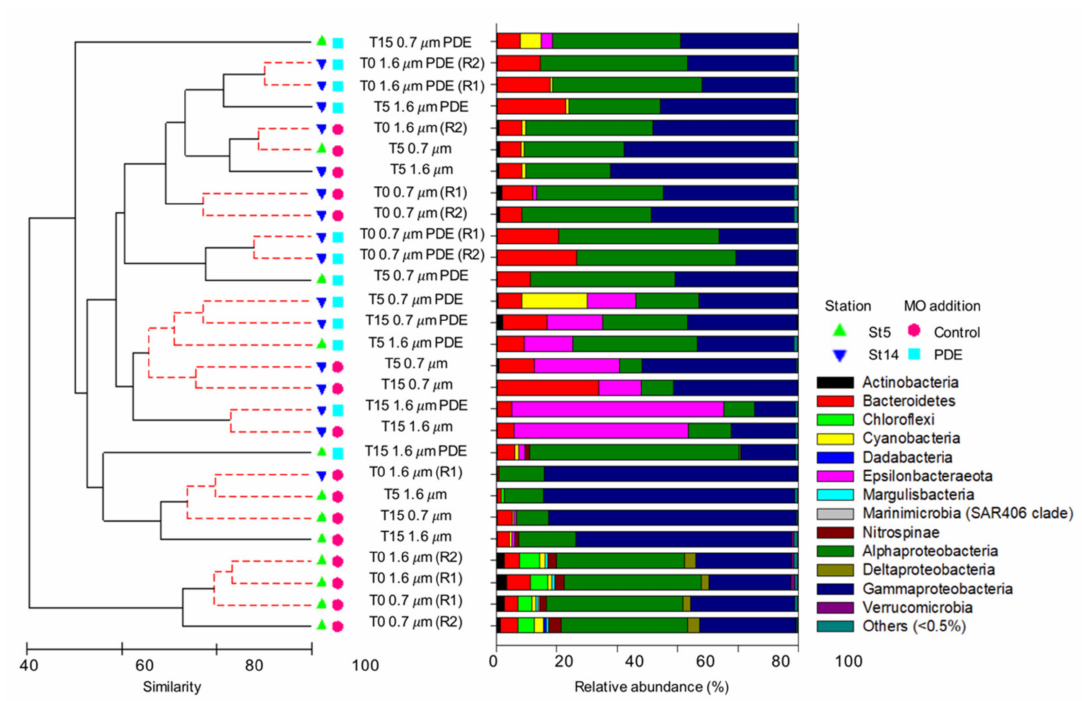
Figure 6. Similarity dendrograms based on the 16S rRNA and relative contribution of the abundant bacteria phyla and Proteobacteria subclasses for both stations and all treatments and incubation times. Clustering was on the basis of a distance matrix computed using the Bray–Curtis index of similarity. The dendrogram was inferred with the unweighted pair-group average algorithm (UPGMA). Bacterial communities in the samples connected with red branch lines are not significantly different (SIMPROF test, p <